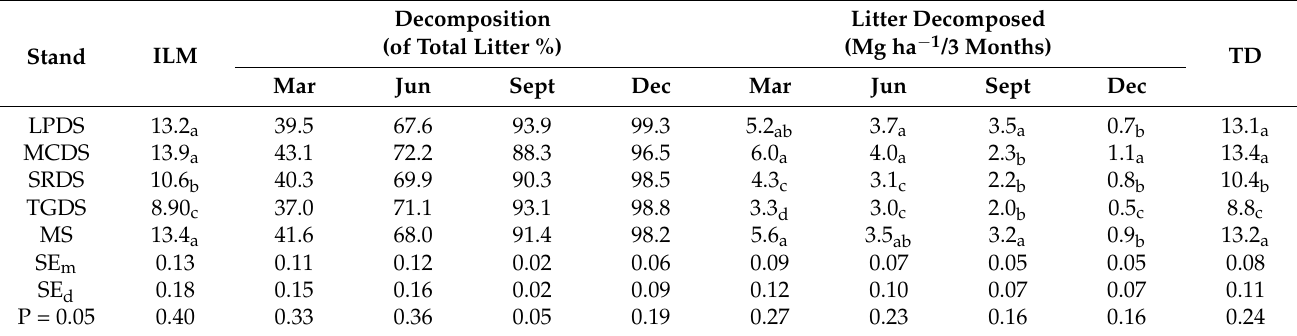
Table 1. Litter production and its progressive decomposition rate in different stands.